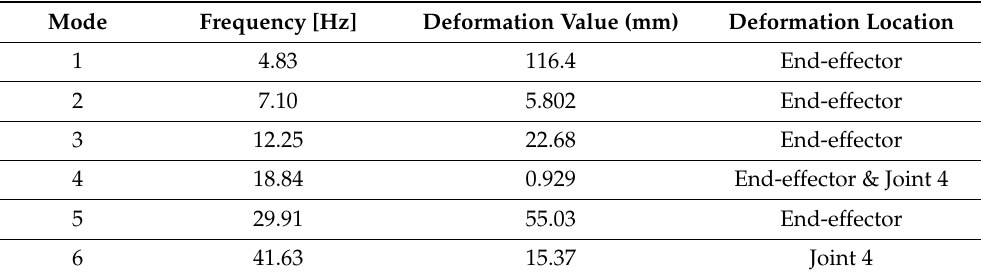
Table 4. Harmonic (forced) analysis results, maximum total deformation values and their locations at the fully-extended configuration; external base excitation was a sinusoidal acceleration with frequencies close to the natural